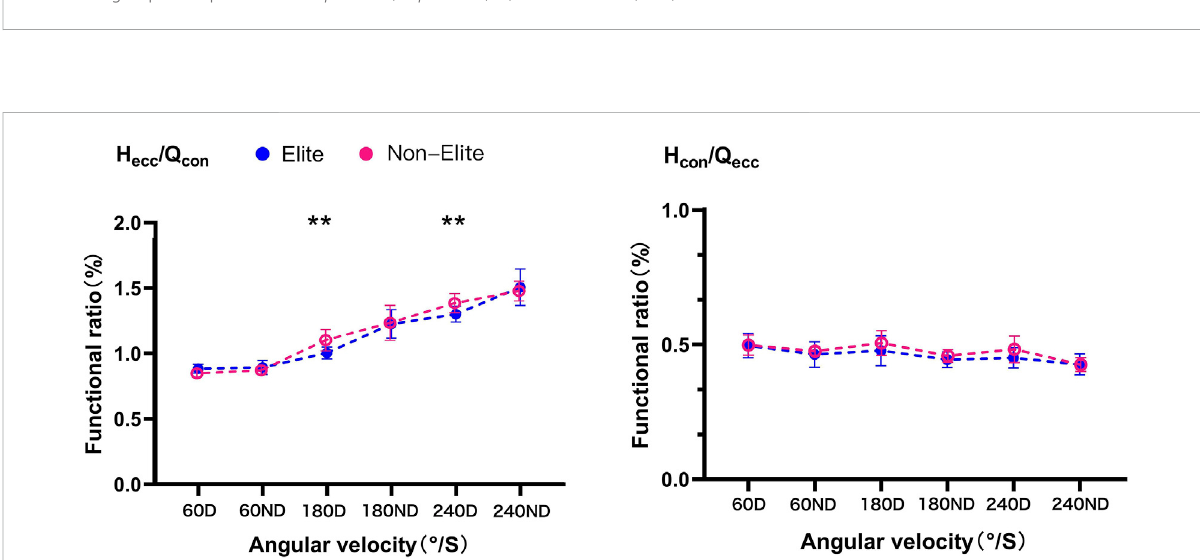
FIGURE 5 Functional ratio against 60 ° /S, 180 ° /S, and 240 ° /S in boxers. Differences between the elite and non-elite group were presented as * p < 0.05, ** p < 0.01; D, dominant limb; ND, non-dominant